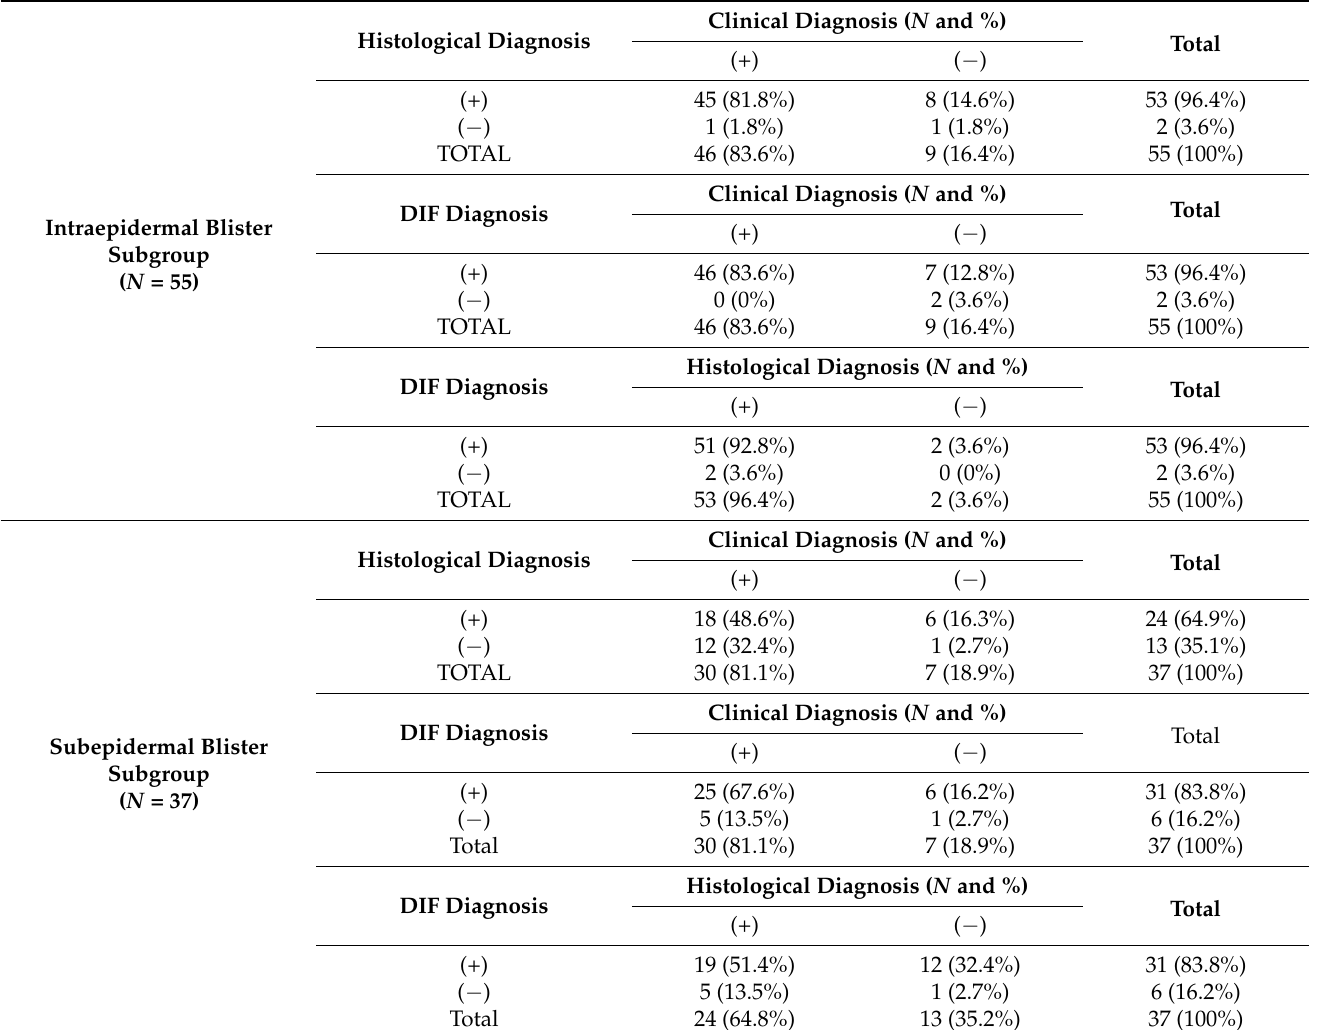
Table 4. Contingency Table For McNemar’s Test Comparing the Diagnostic Accuracy Between the Paired Diagnostic Methods Of the Intraepidermal And Subepidermal Blister Subgroups.